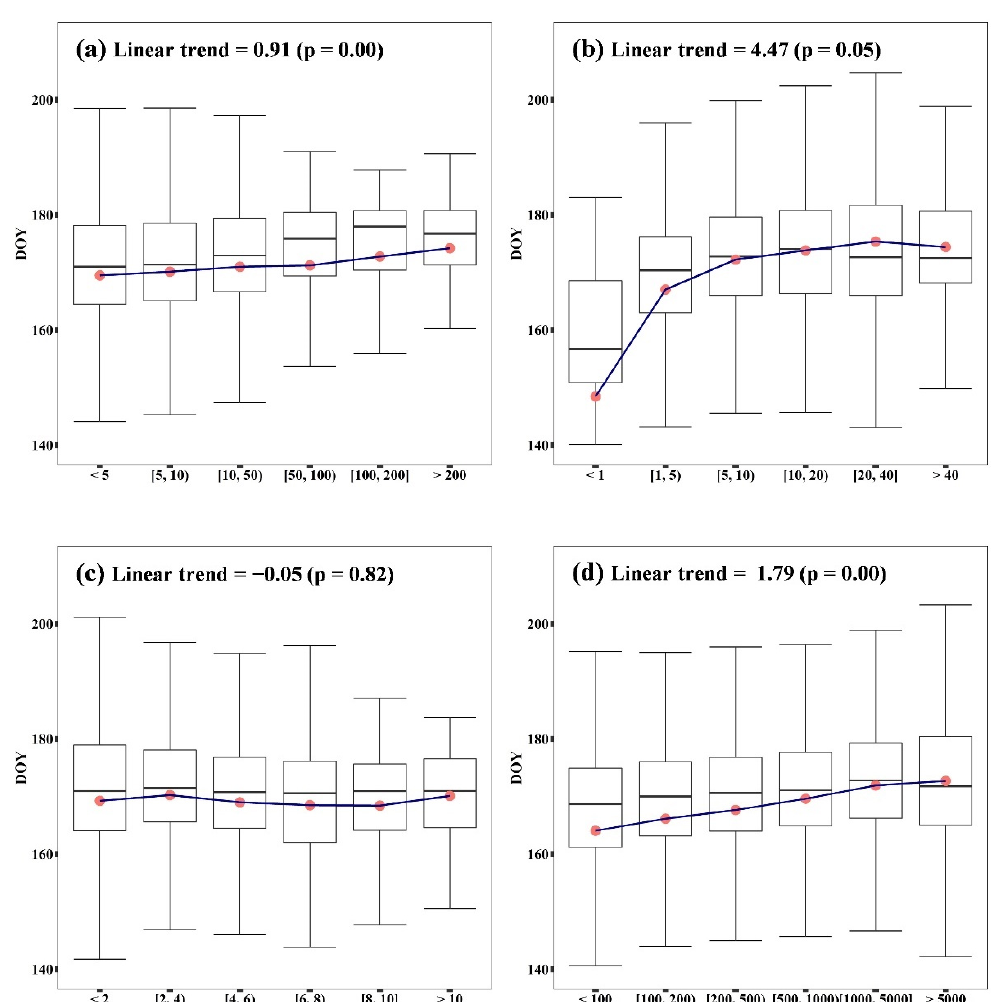
Figure 10. Characteristics of the Pan-Arctic lake ice BUE given ( a ) lake area (km 2 ); ( b ) lake depth (m); ( c ) shoreline development, measured as the ratio between the shoreline length and the circumference of a circle with the same area; ( d ) residence time of the lake waters (day). The linear trend was calculated using the group-aggregated parameter–BUE pair, and the red point denotes the average value of each data group along the x -axis.